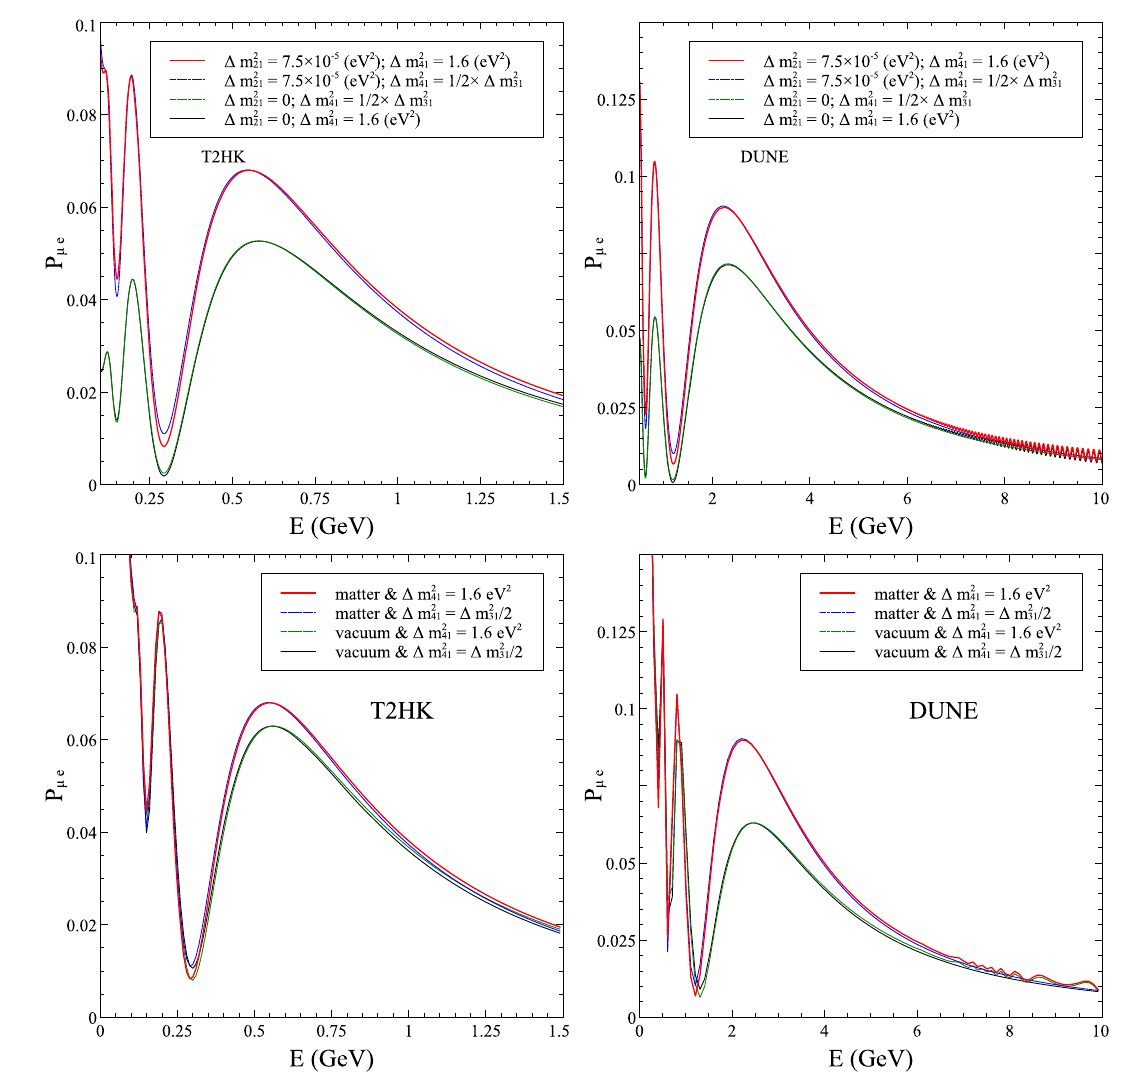
= 1 (cid:2) m 2 case when (cid:2) m 2 . The red solid and blue curves are for 41 31 2 (cid:2) m 2 = 7 . 5 × 10 − 3 eV 2 while the green and black curves are for the 21 = 0. The fast oscillations due (cid:2) m 2 approximate case of (cid:2) m 2 21 been averaged out by Gaussian smearing